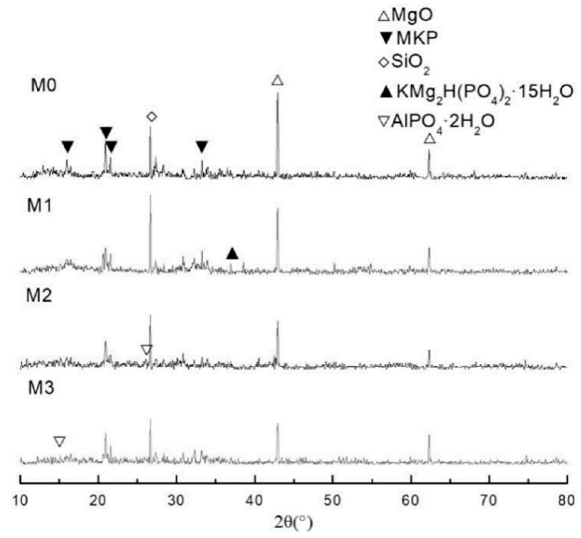
Figure 4. X-ray diffraction (XRD) patterns of MKPC mortar mixed with mineral mixed materials. Figure 4. X-ray di ff raction (XRD) patterns of MKPC mortar mixed with mineral mixed